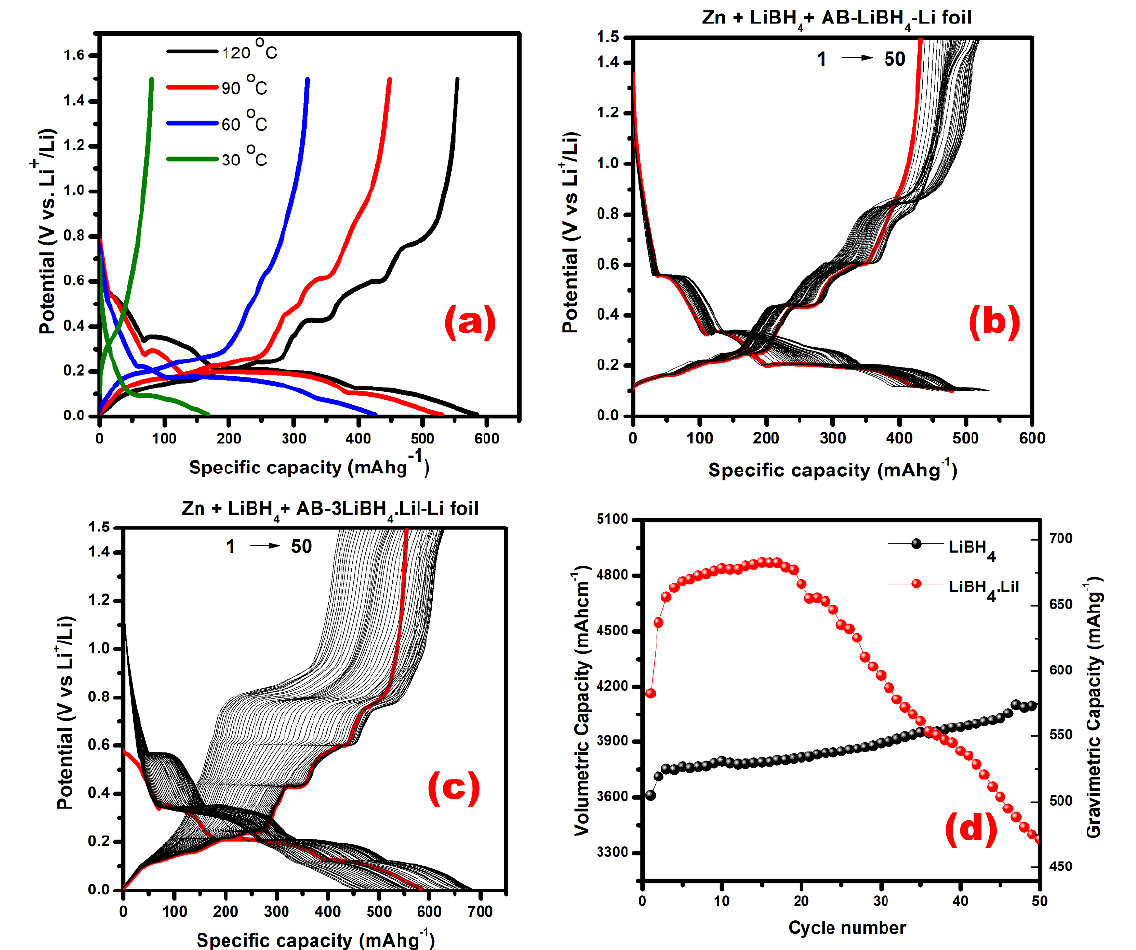
Figure 3. ( a ) Galvanostatic discharge–charge profiles for Zn-LiBH 4 -AB/3LiBH 4 .LiI/Li foil coin cell at different temperatures; ( b ) cycling performance of Zn-LiBH 4 -AB/LiBH 4 /Li foil up to 50 cycles; ( c ) cycling performance of Zn-LiBH 4 -AB/LiBH 4 .LiI/Li foil up to 50 cycles; ( d ) comparison of cyclic stability of composite using two different electrolytes in terms of volumetric capacity vs. cycle number.